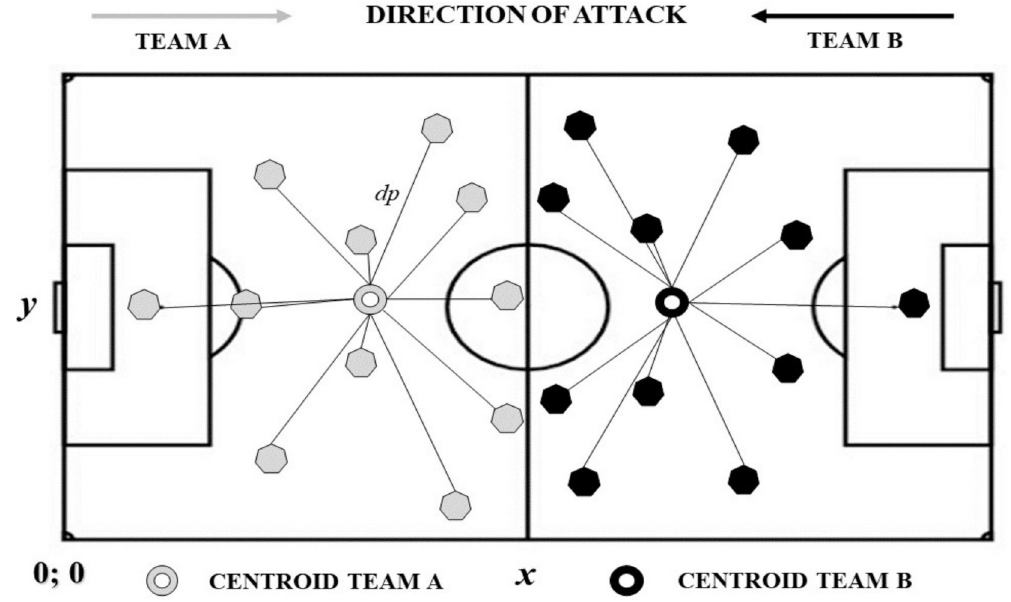
Figure 2 - Illustration of the players, centroid, distances between each player, and the centroid of their team